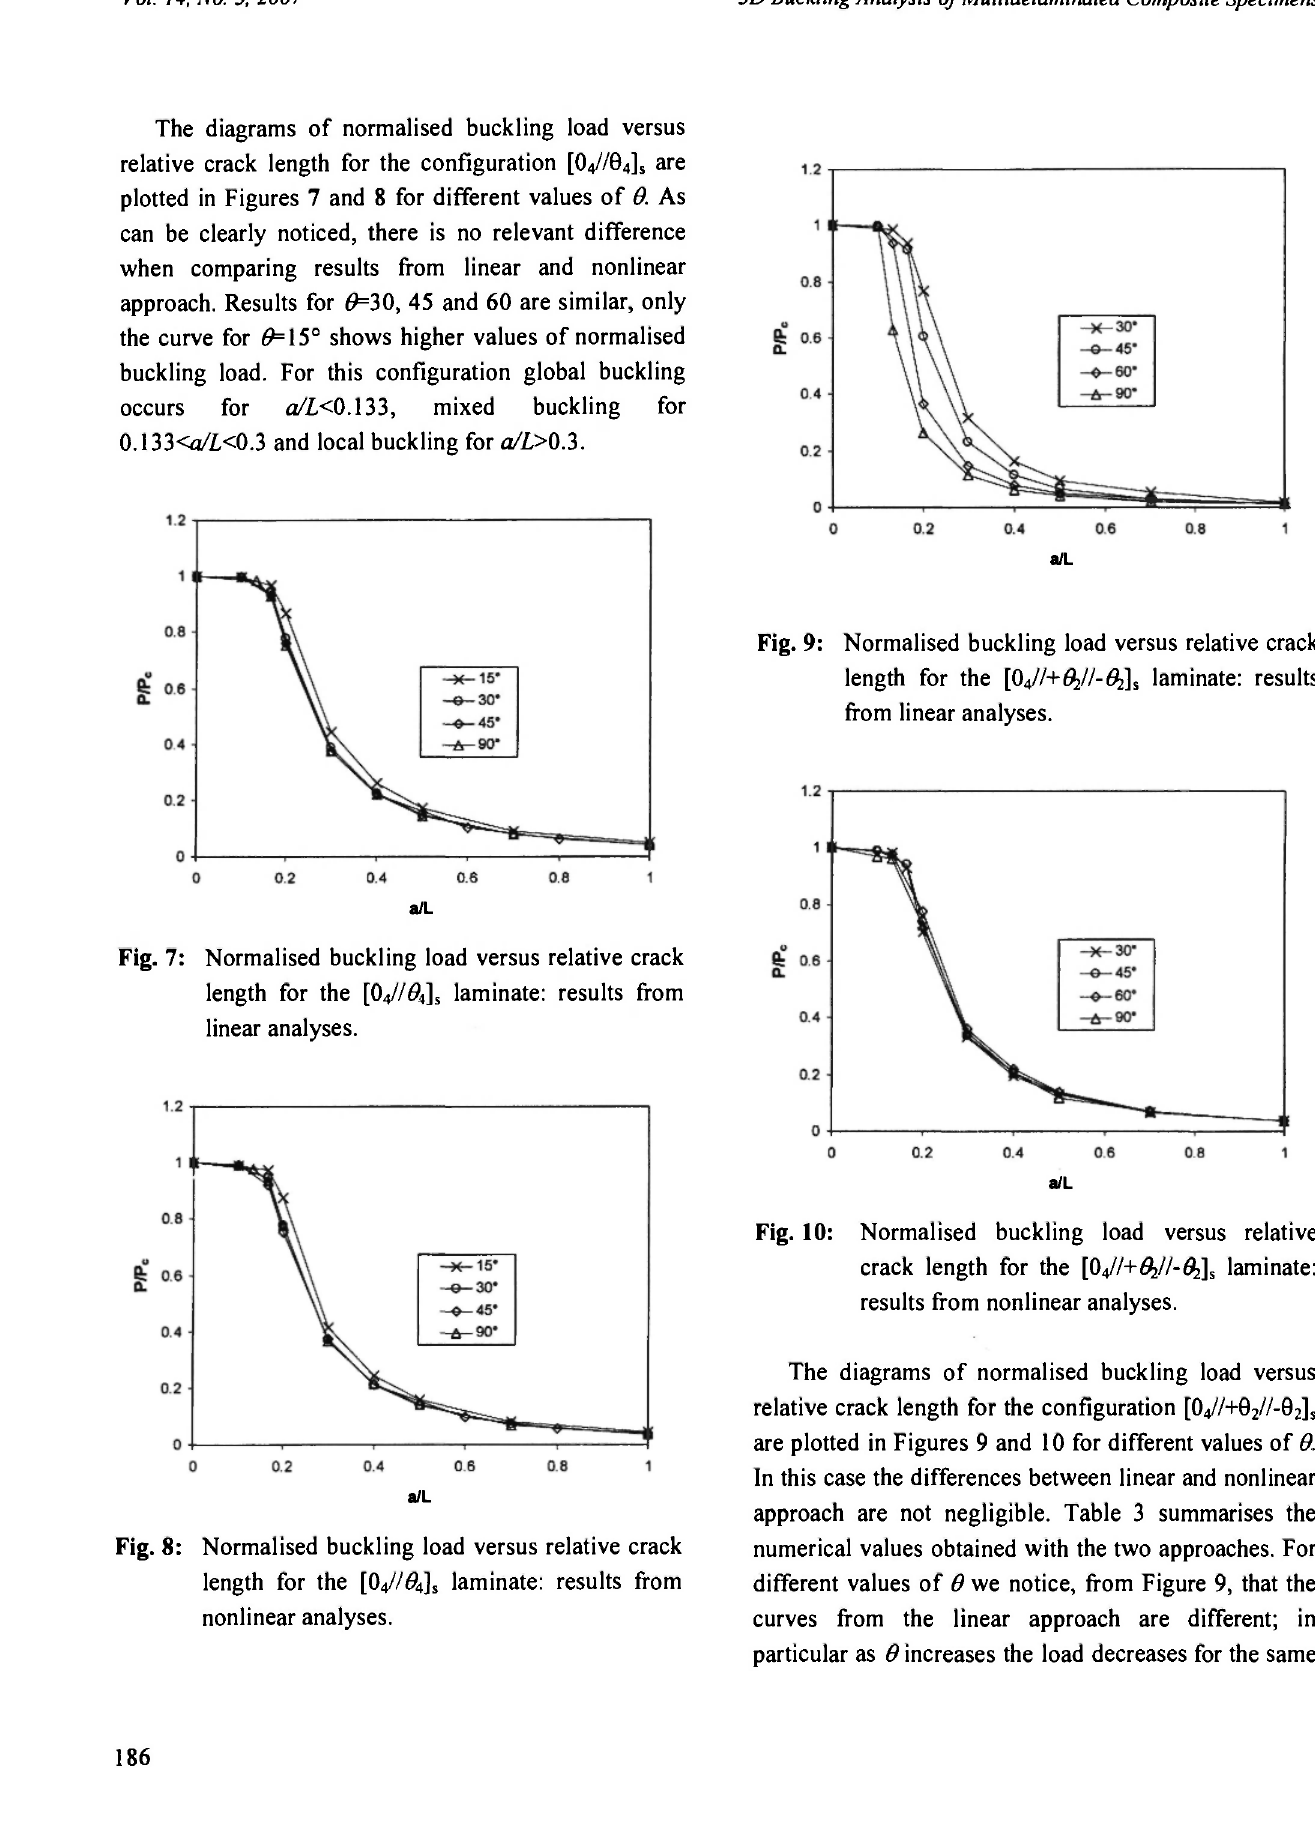
Fig. 10: Normalised buckling load versus relative crack length for the [0JI+(hH-(h]s laminate: results from nonlinear